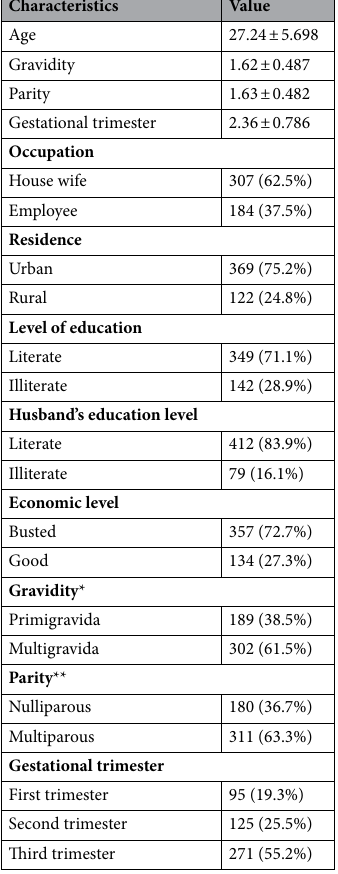
Table 1. Overview of the sociodemographic characteristics of the participants (N = 491). Values are given as mean ± standard deviation or as number (percentage). *Gravidity was defined as the sum of all pregnancies, including all live births and pregnancies that terminated at < 6 months or did not result in a live birth. **Parity was defined as pregnancies that resulted in the delivery at ≥ 6 months gestation, of either a live birth or a stillbirth.